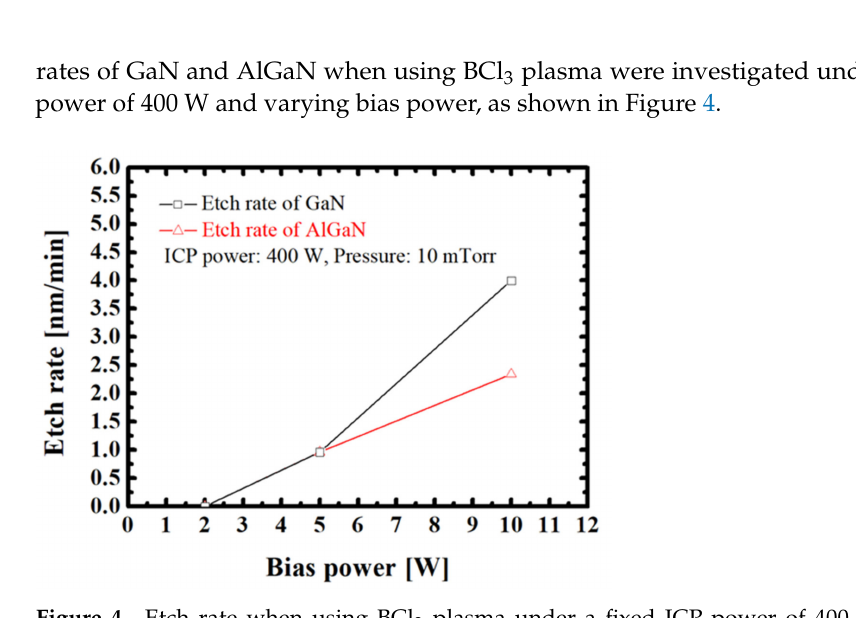
Figure 4. Etch rate when using BCl 3 plasma under a fixed ICP power of 400 W and varying bias powers.